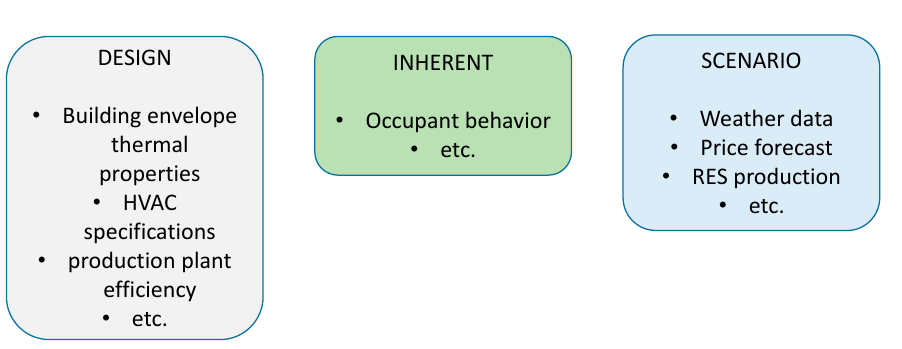
Figure 2. Uncertainty classification.